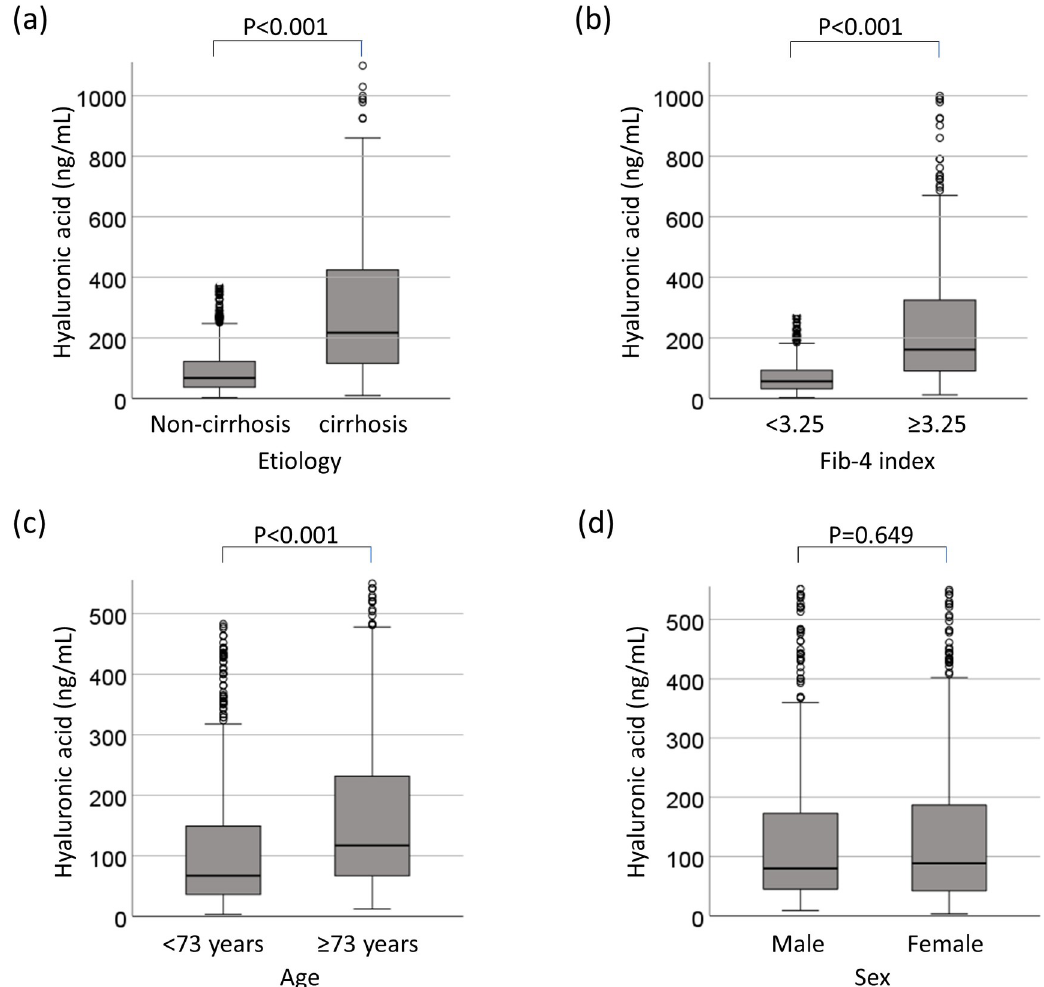
Fig 7. Collinearity between hyaluronic acid and cirrhosis or advanced fibrosis. (a) Comparison of HA in patients with and without cirrhosis. (b) Comparison of HA in patients with Fib4-index values of � 3.25 and < 3.25, (c) Comparison of HA in patients of � 73 years of age and < 73 years of age, (d) Comparison of HA in males and females. HA, hyaluronic acid. twenty-three patients (38.3%) had AFP levels above the upper limit (10 ng/mL), and 27 patients (45.8%) had DCP levels above the upper limit (40 mAU/mL). Twenty-two of 39 patients (56.4%) with EOT-AFP � 5.3 ng/mL had levels above the upper limit at the onset of HCC. However, only 1 of 21 patients (4.8%) with EOT-AFP < 5.3 ng/mL had a level above the upper limit (p < 0.001). Similarly, AFP increased more than 30% at the onset of HCC in 19 of 39 patients (48.7%) with EOT-AFP � 5.3 ng/mL, but only increased in two of 21 patients (9.5%) with EOT-AFP < 5.3 ng/mL (p < 0.001). On the other hand, among patients with EOT-AFP < 5.3 ng/mL, the percentage of patients with DCP levels above the upper limit at the onset of HCC was similar to that of patients with EOT-AFP � 5.3 ng/mL (p = 0.477). In addi- tion, 22 patients (37.3%) had AFP and DCP levels within the normal limits at the onset of HCC. Among patients with EOT-AFP < 5.3 ng/mL, a significantly higher percentage of patients had normal limits of AFP and DCP in comparison to those with EOT-AFP � 5.3 ng/ mL at the onset of HCC (p = 0.020).